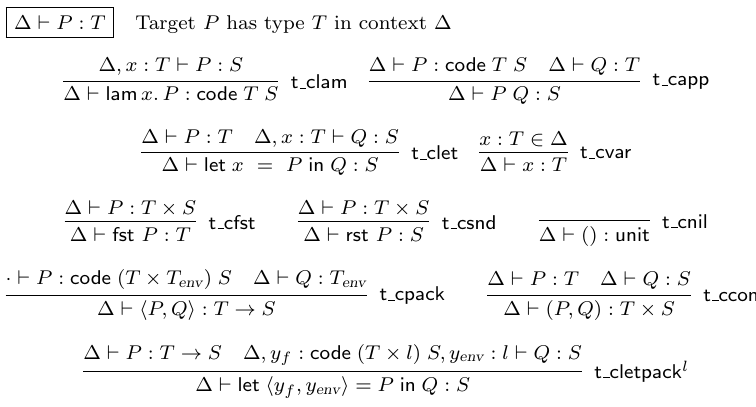
Fig. 9. Typing Rules for the Target Language of Closure